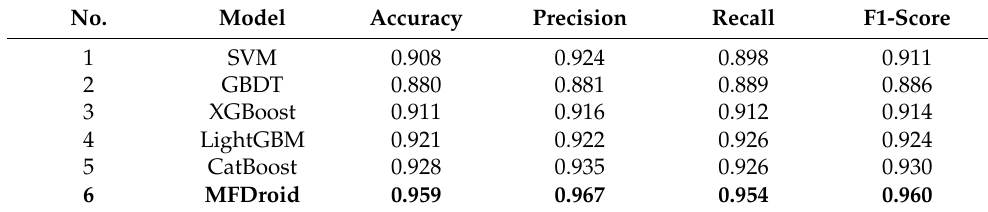
Figure 11. ROC curve of MFDroid and single classifier.